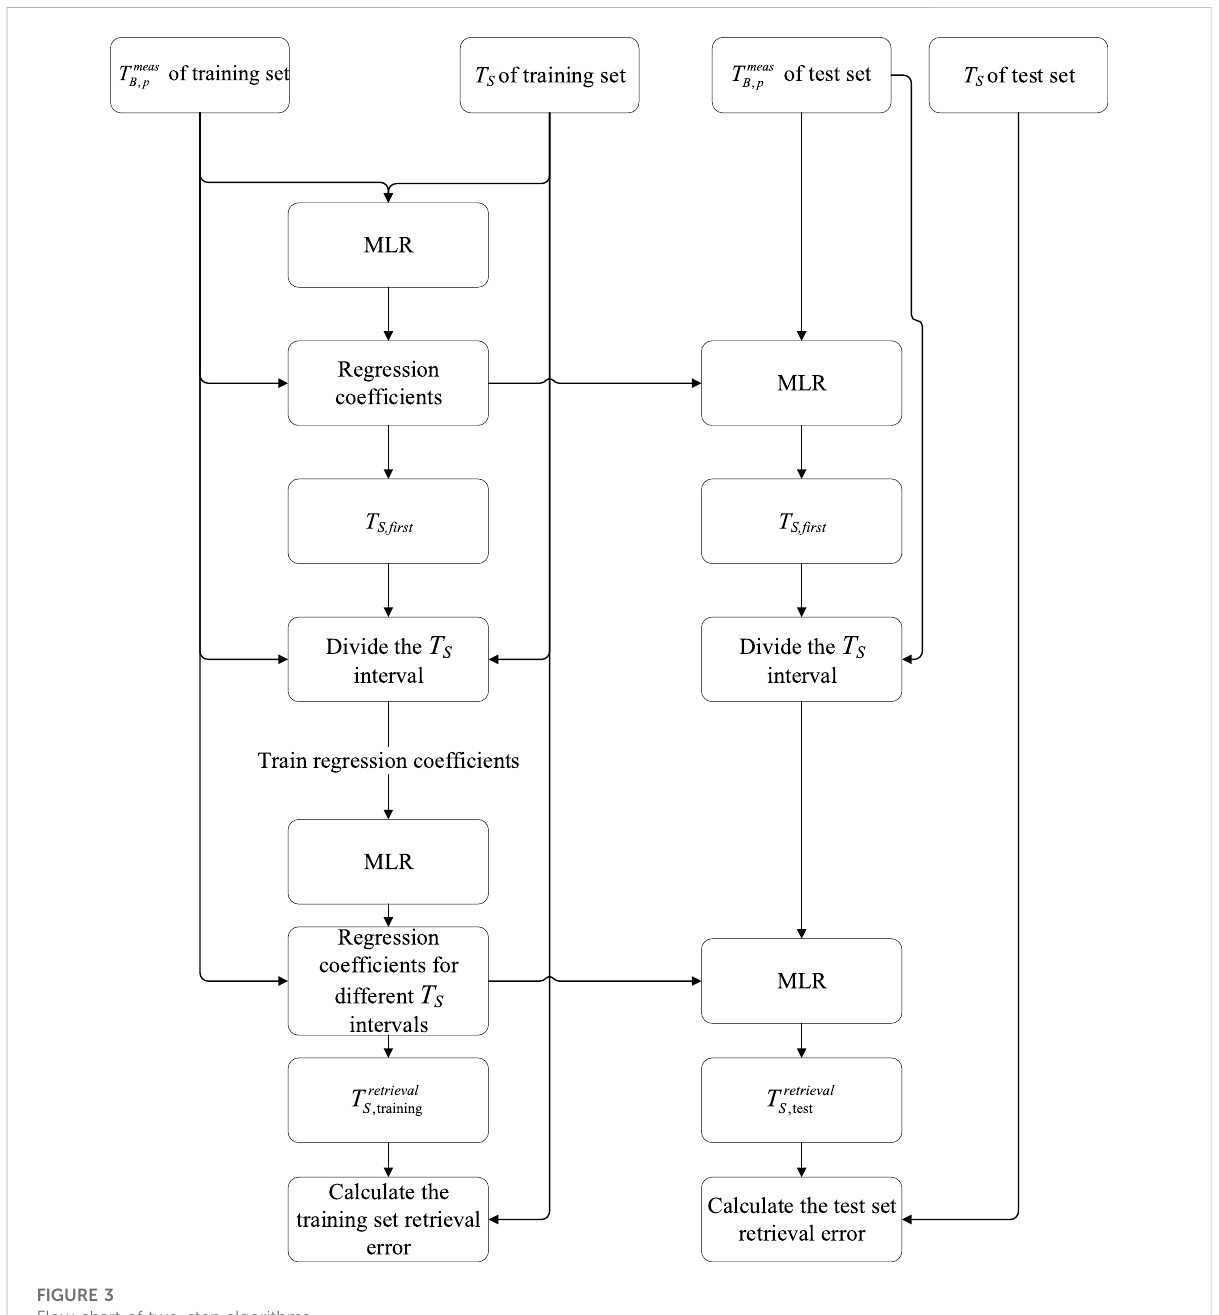
FIGURE 3 Flow chart of two-step